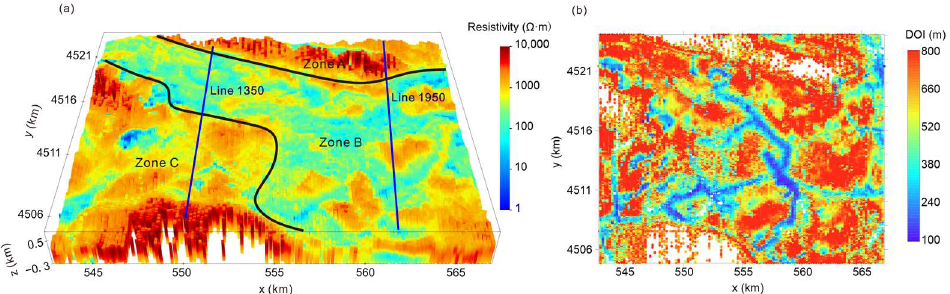
Figure 6. The resistivity model and depth of investigation for this model. ( a ) The resistivity model obtained by SCI inversion. Due to the poor quality of the raw data or severe noise interference, there are some blank areas in the figure. The interpolated 50-m depth slice of the resistivity model is given in Figure 7. The whole survey area can be roughly divided into three regions: Zone A, Zone B and Zone C. The boundary of the three parts is shown in black curves. The two blue lines correspond to the cross-section locations shown in Figures 8 and 9. ( b ) The depth of investigation for the resistivity model.